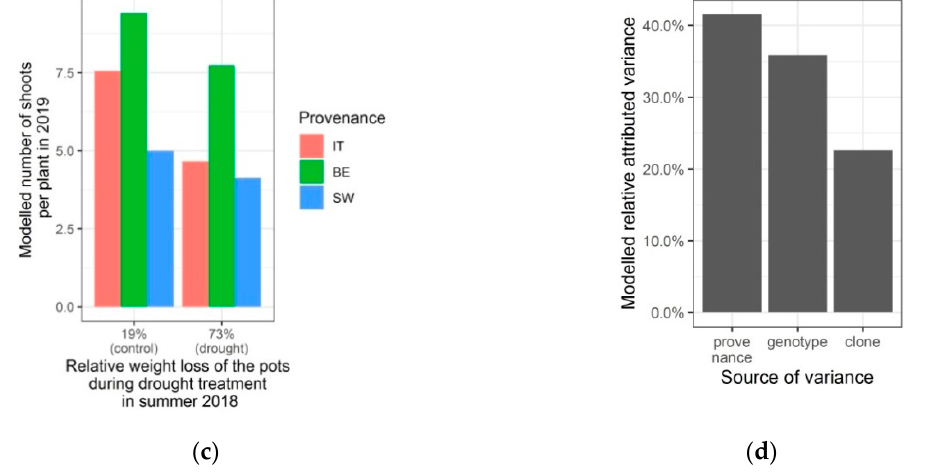
Figure 11. Size of the largest shoot and plant architecture in 2019. ( a ) Length and diameter of the largest shoot per plant at the end of 2019; ( b ) Distribution of modelled relative variance for the size measurements on the largest shoot per plant, with the factors provenances, genotypes within a provenance and clones within a genotype; ( c ) Modelled number of shoots per plant, depending on the provenance and on the relative weight loss of the pots during the treatment in 2018; ( d ) Distribution of modelled relative variance between the provenances, between the genotypes within a provenance, between the clones within a genotype and residual variance for number of shoots per plant. IT: Italian provenance, BE: Belgian provenance, SW: Swedish provenance.